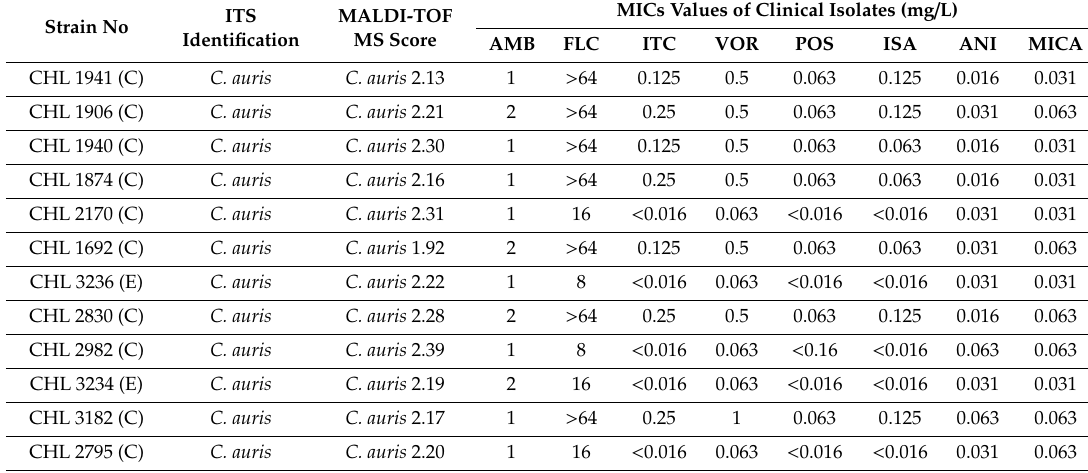
Table 2. MIC values of 12 Candida strains from the